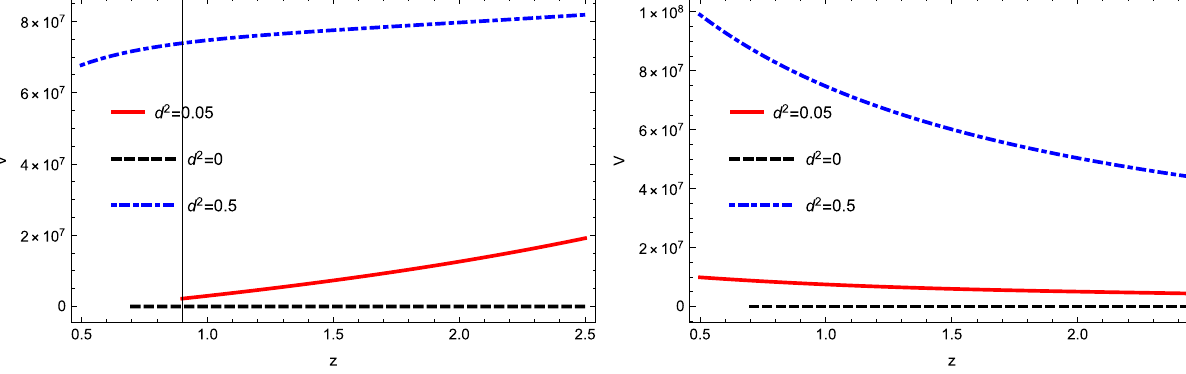
Fig. 20 Plot of V verses z for u = 1 and u = 2 . 002 for quintessence scalar field model